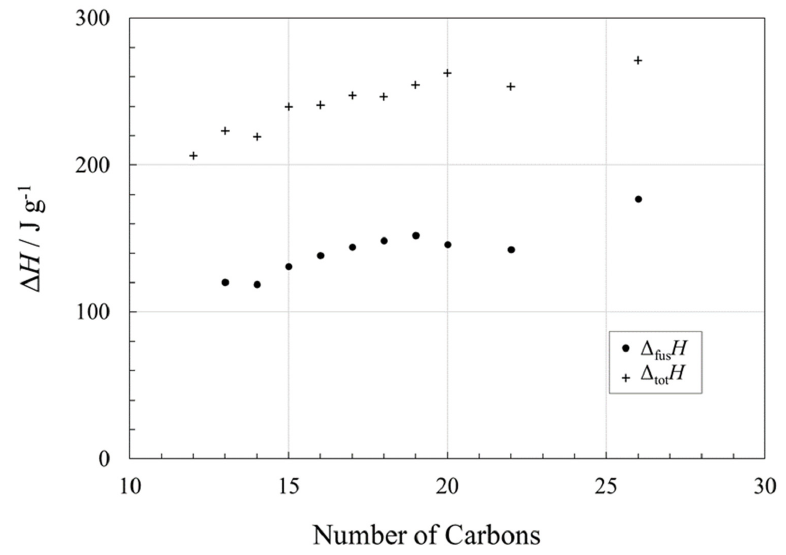
Figure 6. Enthalpy changes ( Δ H in J g − 1 ) associated with phase transitions in linear 1-alcohols, as a function of chain length, n . Circles ( ● ) represent the enthalpies of fusion, Δ fus H , and crosses ( + ) rep- resent the total enthalpy changes of fusion plus that from solid–solid transition(s), if present, Δ tot H . See Supplementary Information for data and data sources. Solid–solid transitions in the long-chain alcohols take place prior to melting [70] and they can have considerable associated enthalpy changes [15]. However, the difference be- tween the temperature of the solid–solid transition(s) and the melting point are generally very small, ~3 K for 1-decanol, and ~1 K for 1-dodecanol, 1-tetradecanol, 1-hexadecanol, and 1-octadecanol [89]. As for the alkanes, the full enthalpy change ( Δ s-s H + Δ fus H ) can be accessed for thermal energy storage if the PCM operational temperature range is suffi- ciently broad. For a given melting point (Figure 1), Δ fus H in J g − 1 of a fatty alcohol is similar to that for the corresponding alkane, although the alcohol would have a shorter chain length. Therefore, use of an alcohol could provide an economic benefit. 3.4. Fatty Acids Linear saturated fatty acids with even numbers of carbon atoms in the chain, form one of three polymorphs (A, B, C) in the solid phase, with subtle differences in tilt angle and the head group relative to the tail [90]. The C phase grows from the melt and there can be subtle solid–solid transitions, such as the one at ~200 K in dodecanoic acid [91]. The enthalpies of fusion of long chain fatty acids as a function of chain length are shown in Figure 7. There are noticeable odd–even effects, again with higher values of Δ fus H for even numbers of carbons, again likely due to their more efficient packing. Since